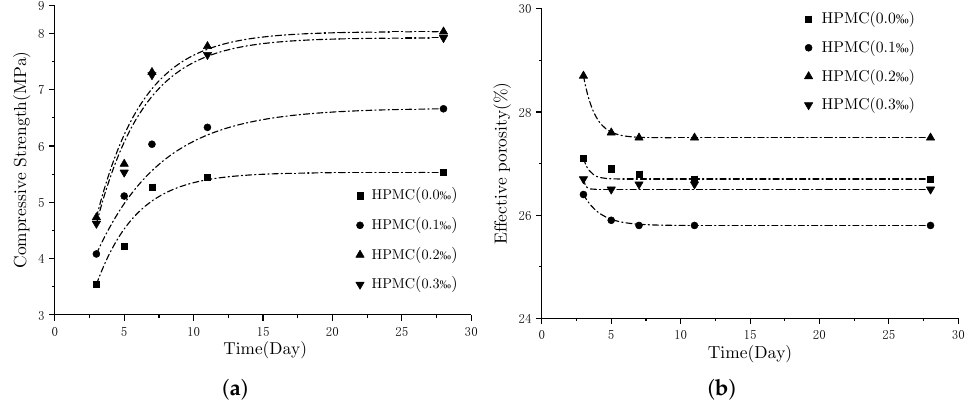
Figure 5. Relationships of strengths and porosities versus time for the porous concrete with different dosages of HPMC. ( a ) Strength–time curves for PC-0, 1, 2, and 3; ( b ) porosity–time curves for PC-0, 1, 2, and